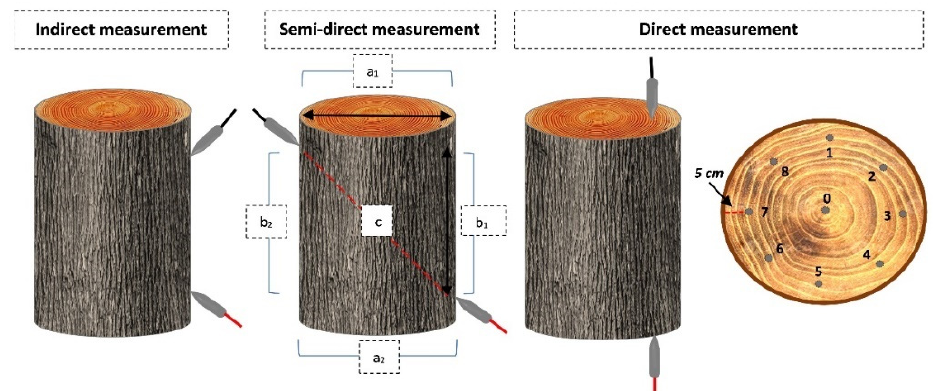
Figure 1. Three different configurations of longitudinal measurements on standing trees and logs: indirect, semidirect and direct. In semidirect measurements, to determine the lengths of the right triangle, an average of a 1 , a 2 and b 1 , b 2 was